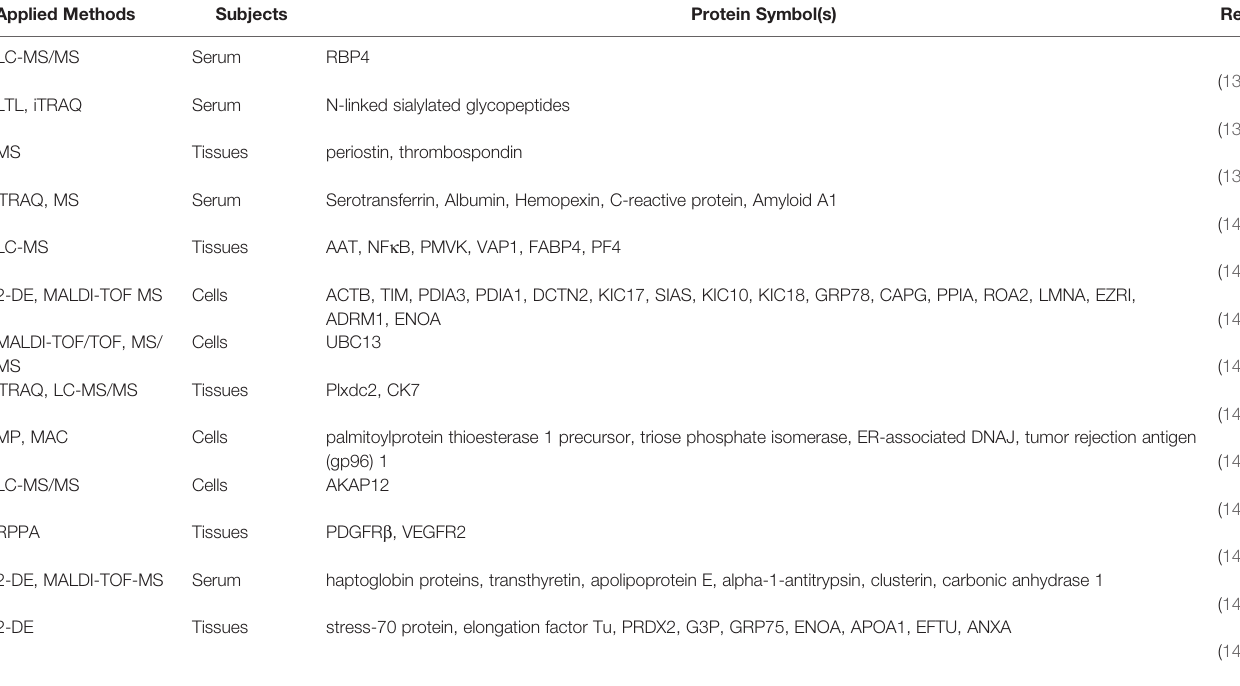
TABLE 3 | The application of proteomics for exploring the candidate biomarkers for ovarian cancer. Applied